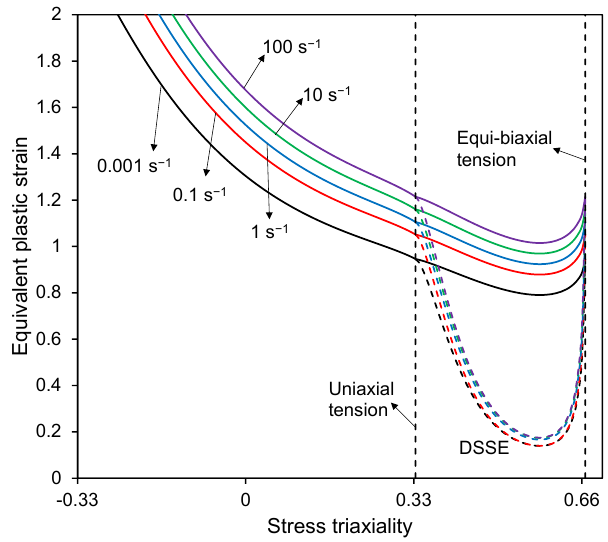
Figure 6. Localized necking and fracture loci at various strain